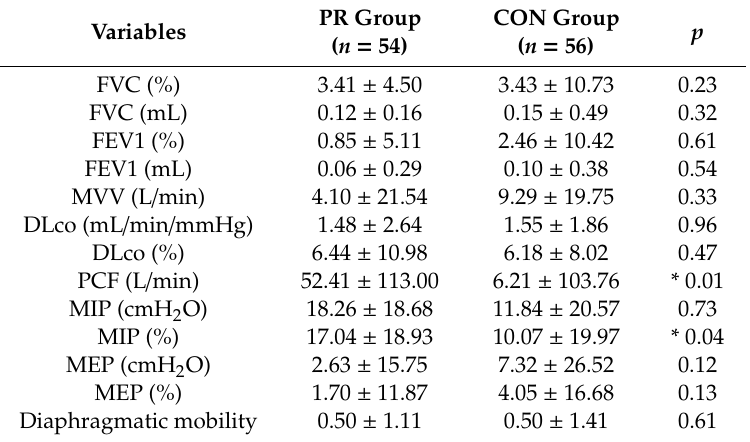
Table 3. The changes of pre-intervention and post-intervention in both groups.